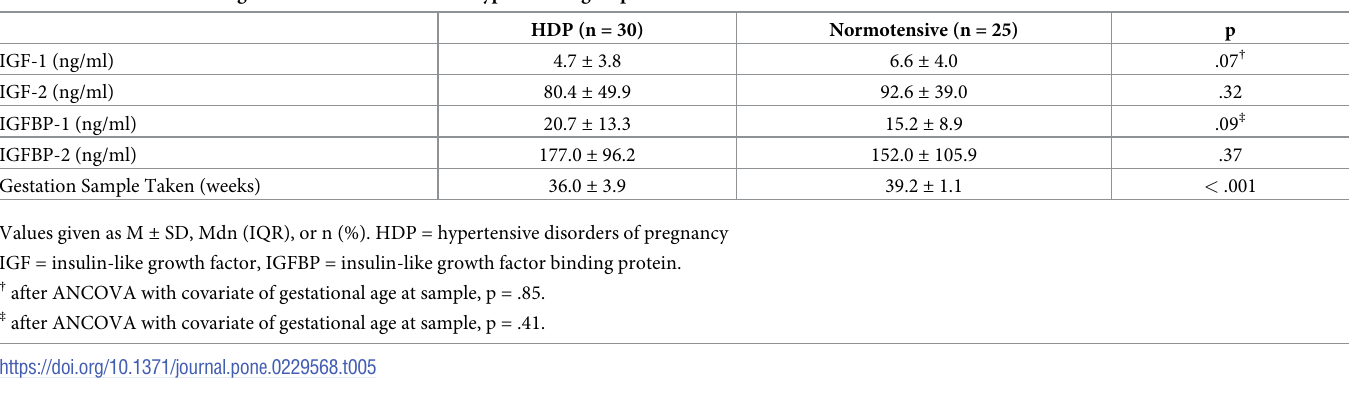
Table 5. Biomarkers of fetal growth in cord blood across hypertensive